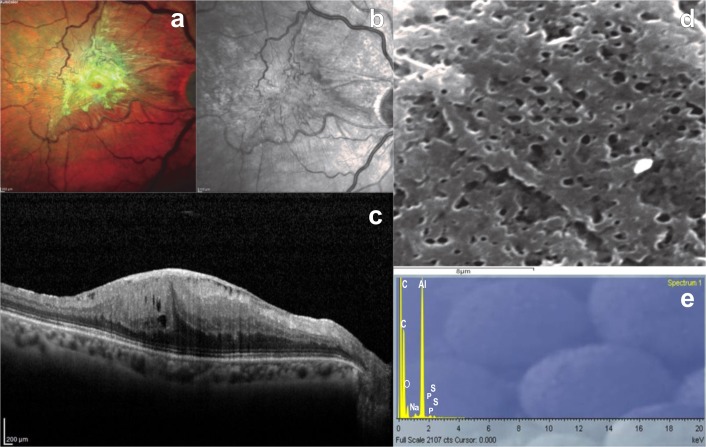
Analysis of a sample ERM with folded appearance at SEM.a-c) Multicolor image, infrared and structural OCT B-scan showing significant epiretinal proliferation; d) Scanning electron microscope sample revealing fibrotic folded tissue; e) SEM/EDS analysis showing the mineral composition of the sample: sulphur, sodium and phosphorus are the most frequent elements.